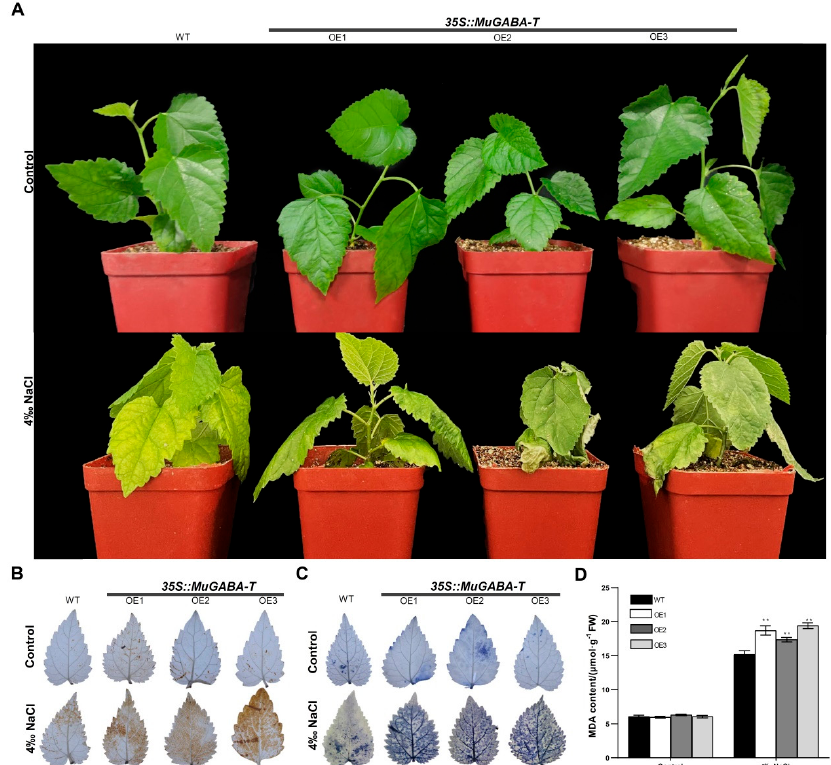
Figure 7. Salt sensitivity of the mulberry seedlings carrying the transgenic MuGABAT hairy roots. ( A ) Phenotypes of mulberry seedlings carrying hairy roots upon 4‰ NaCl treatment. Accumulation of superoxide ( B ) and H 2 O 2 ( C ) in the mulberry seedlings carrying hairy roots upon NaCl treatment. The purple-blue staining indicates formazan deposits produced by superoxide anion reacting with NBT and the brown coloration indicates the polymerization product formed by H 2 O 2 reacting with DAB. ( D ) MDA content in the leaves of the mulberry seedlings carrying hairy roots. Data are expressed as the average of three independent replicates ±SD, and the double asterisks indicate significant differences at p < 0.05. WT represents the mulberry seedlings carrying the transgenic empty vector hairy roots, and 35S::MuGABA ‐ T represents the mulberry seedlings carrying the transgenic MuGABA ‐ T hairy roots. OE1 ‐ OE3: MuGABA ‐ T transgenic lines.